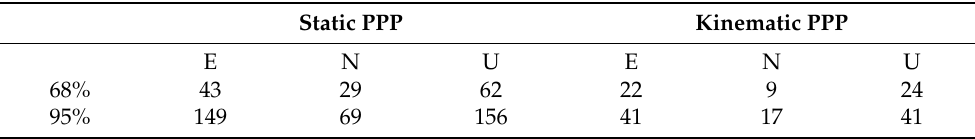
Table 12. Convergence time of the QF method (unit: min) (G/R/B). Static PPP Kinematic PPP